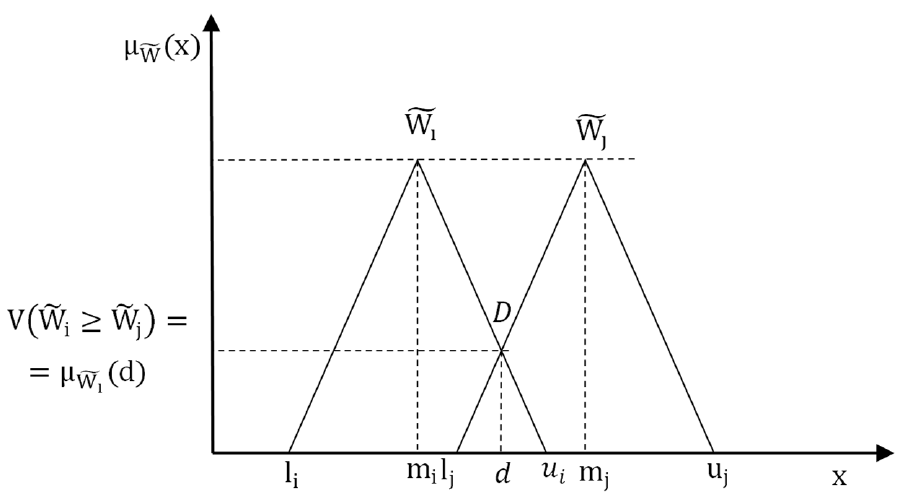
Figure 2. Determination of the coordinates of the point of intersection (cid:101) W i and (cid:101) W j .